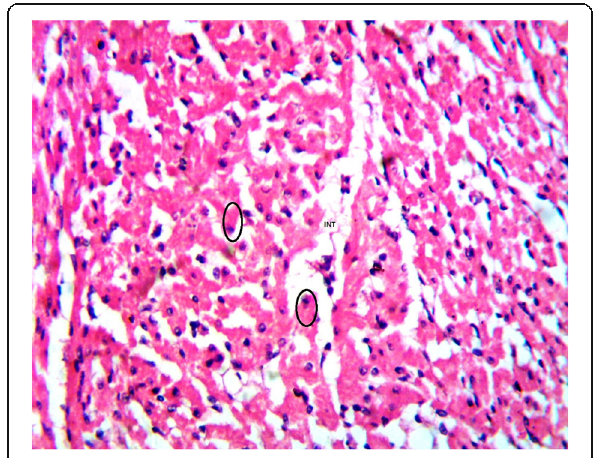
Fig. 5 Liver section of broiler chicken fed 4.0% of PCHM-inclusive